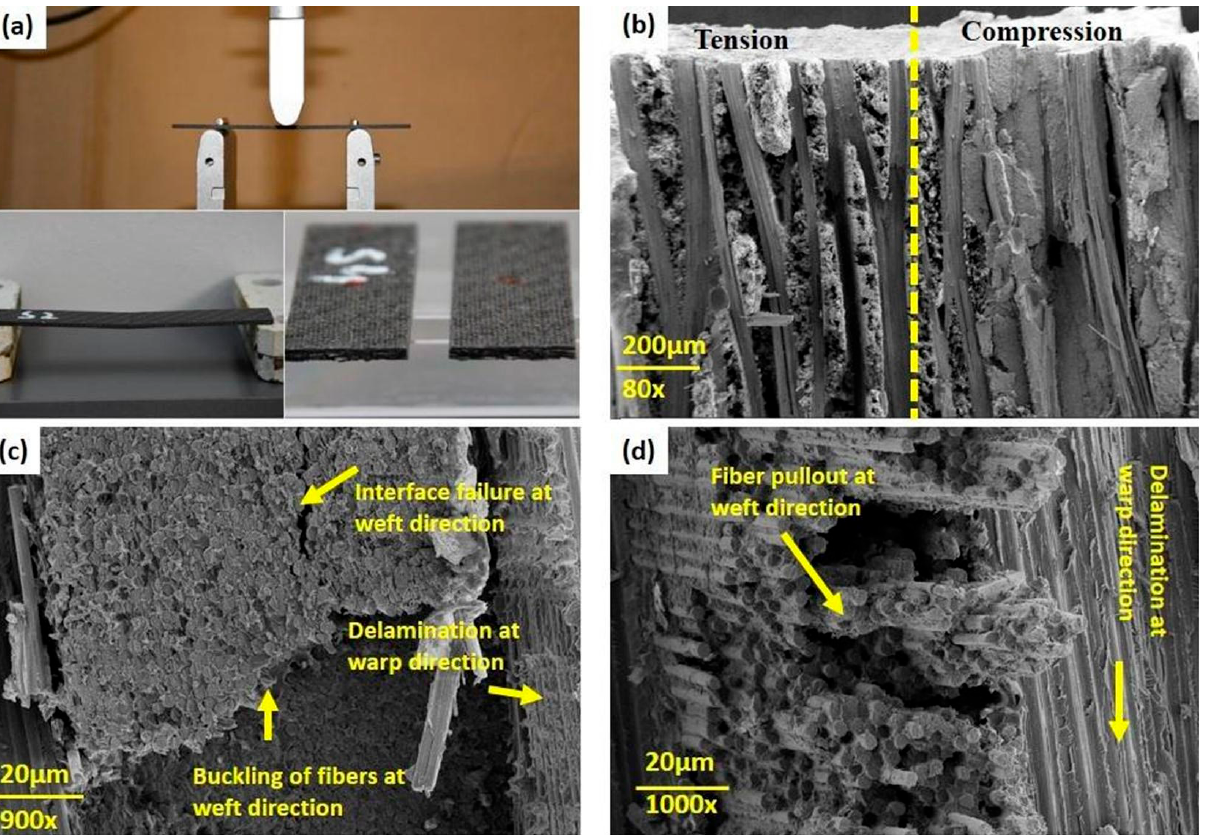
Figure 35. ( a ) Fractured/damaged composite specimen; ( b – d ) an illustration of different failure modes induced by three-point cyclic bending loading, adapted with permission from Ref.